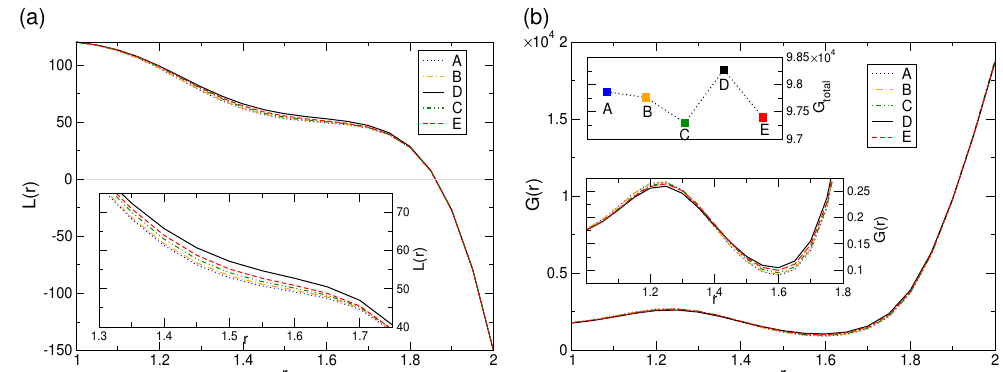
Figure 13. Variation in ( a ) the angular momentum L ( r ) = r (cid:104) v ( r ) (cid:105) θ , z /Re i and ( b ) the dimensionless torque G = ν J ω (see text for details) versus the radius r for solutions during the transition (indicated (A)–(E) in Figure 11( a ). The insets in ( a ) show a close up of L ( r ) and in ( b ) shows the total torque G total . Torque Variation with